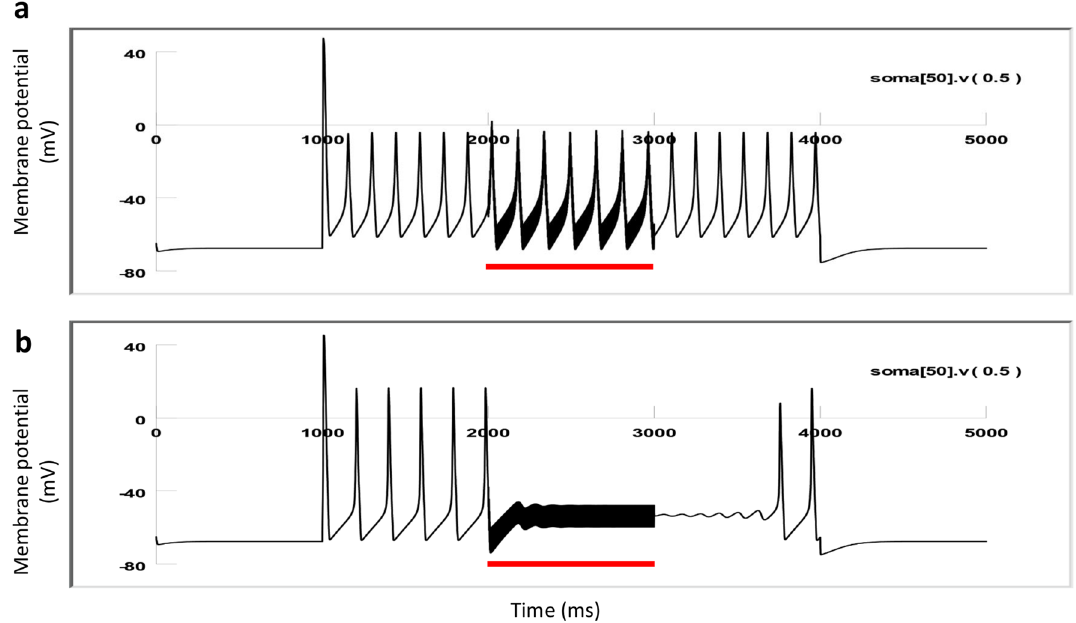
Figure 9. Neural inhibition by the magnetic field is dependent on the active state of the neuron. 400 Hz coil stimulation (red lines) was applied to the modeled neuron. ( a ) 35 nA depolarization current elicited high firing frequency (7 Hz) and the magnetic stimulation failed to inhibit the neuronal activity. ( b ) 20 nA depolarization current elicited moderate firing (5 Hz) and the magnetic stimulation inhibited neural activity instantly.